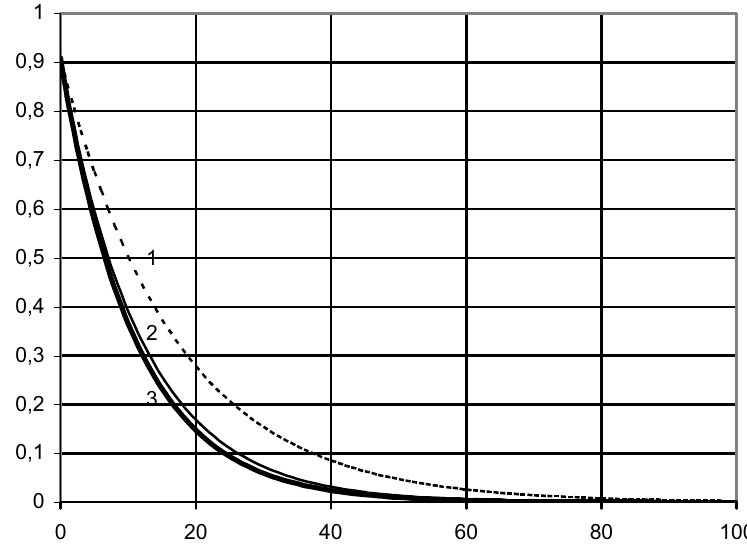
Figure 1 – Exponential, with mean 1, (cid:79) =1/1.1, d